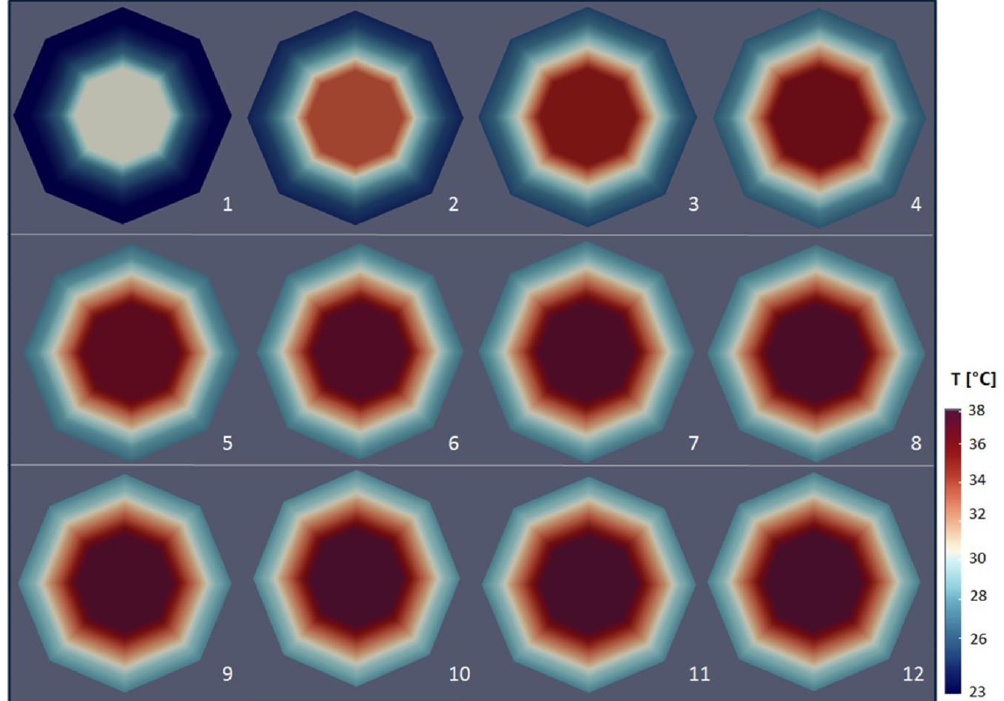
Figure 11. Heat transfer between the working fluid (water) and the surrounding material (silica sand with 15% humidity) according to the temperature values recorded by sensors S1–S5: Step 1 = 21,600 s, step 2 = 43,200 s, step 3 = 64,800 s, step 4 = 86,400 s, step 5 = 108,000 s, step 6 = 129,600 s, step 7 = 151,200